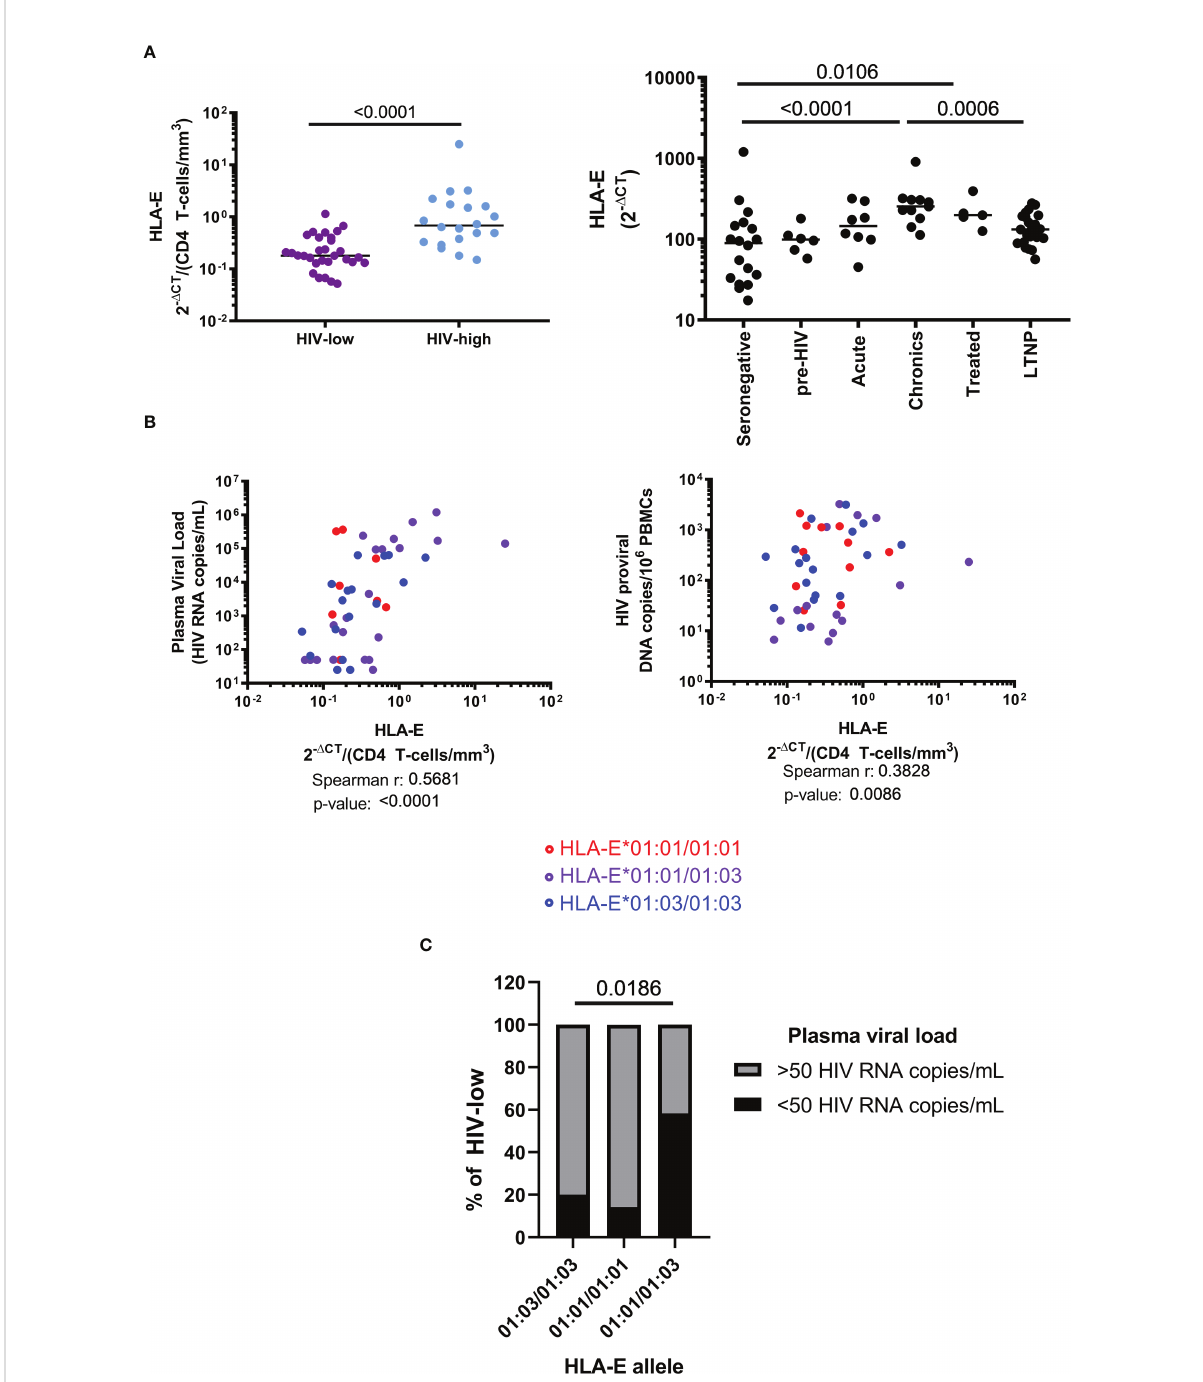
FIGURE 1 Role of HLA-E allele haplotypes and expression level during HIV infection. (A) HLA-E mRNA expression, measured by qPCR and corrected by CD4 count, is reduced in HIV-low individuals (n=31) compared to HIV-high (n=20) individuals (left). HLA-E expression progressively increases during natural course of HIV infection (right). (B) HLA-E expression levels correlated positively with plasma viral loads and HIV viral reservoir size (determined as copy number of integrated proviral DNA). HLA-E allelic differences showed no difference in terms of HLA-E expression, plasma viral load and reservoir size. (C) Frequency of HLA-E genotypes within the HIV-low group (n=31). Mann-Whitney test was performed to compare differences between groups (A) , Spearman ’ s rank correlation coef fi cient was applied to evaluate correlations (B) and Chi-square was performed to determine the signi fi cance of HLA-E haplotype frequencies among HIV natural controllers (C) . Results were considered statistically signi fi cant when p-value <0.05 while trends are indicated in